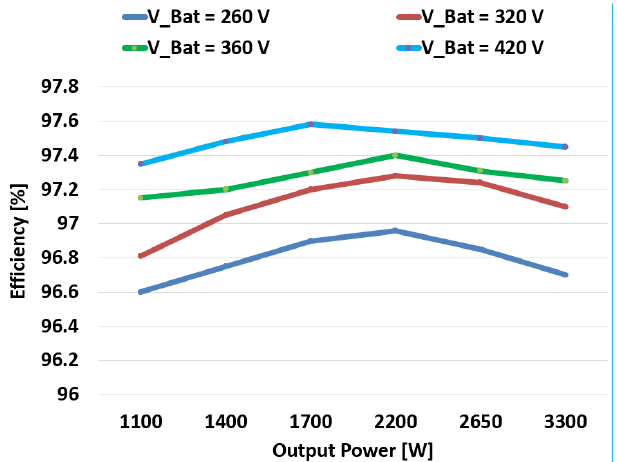
Figure 21. Efficiency plots during function II operation with wide range of input voltage